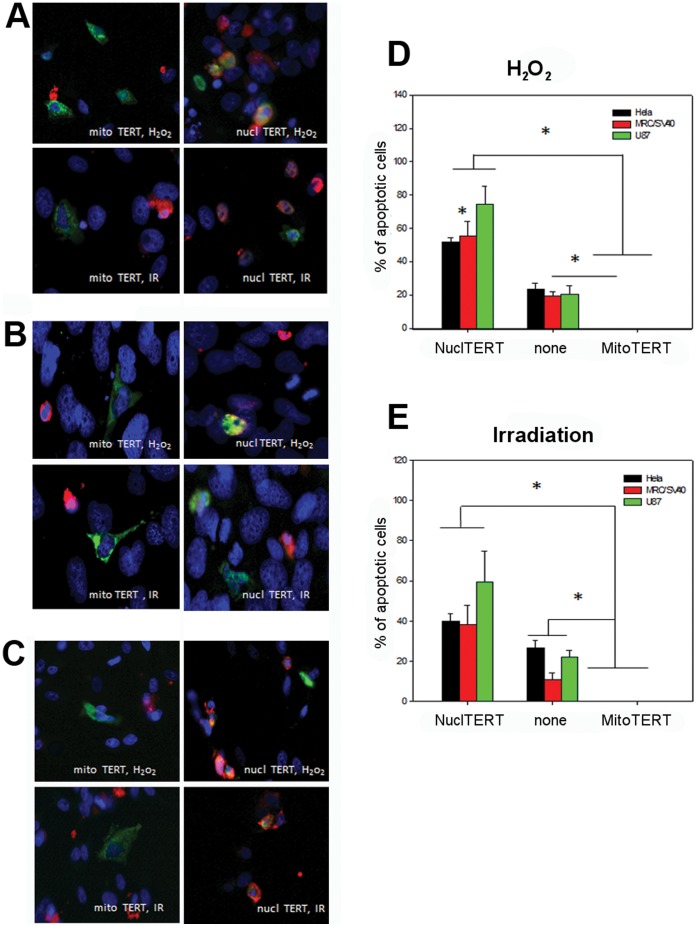
Mitochondrial TERT protects from apoptosis induction after H2O2 treatment and X-irradiation compared to cells transfected with nuclear TERT.Representative images of activated caspase 3 (shown in red) in A: Hela, B: MRC/SV40, C: U87 cells transfected with mito TERT and nuclear TERT (myc-tag, shown in green) after 400 µM H2O2 treatment for 3 h or irradiation with 20 Gy. D: Quantification of the percentage of apoptotic cells of the 3 cell lines after H2O2 treatment, E: Quantification of the percentage of apoptotic cells of the 3 cell lines after X-irradiation. Bars present mean and standard error from around 45 transfected cells per condition and cell line. * p<0.05.